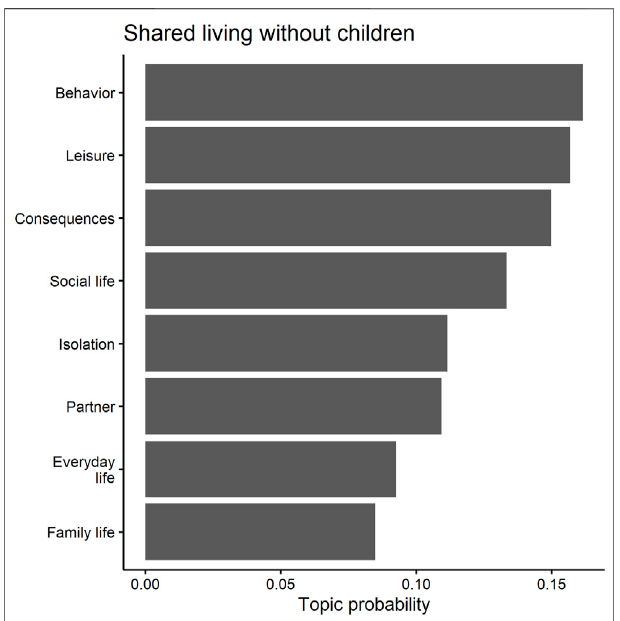
FIGURE 8 | Predicted topic probabilities for shared living without